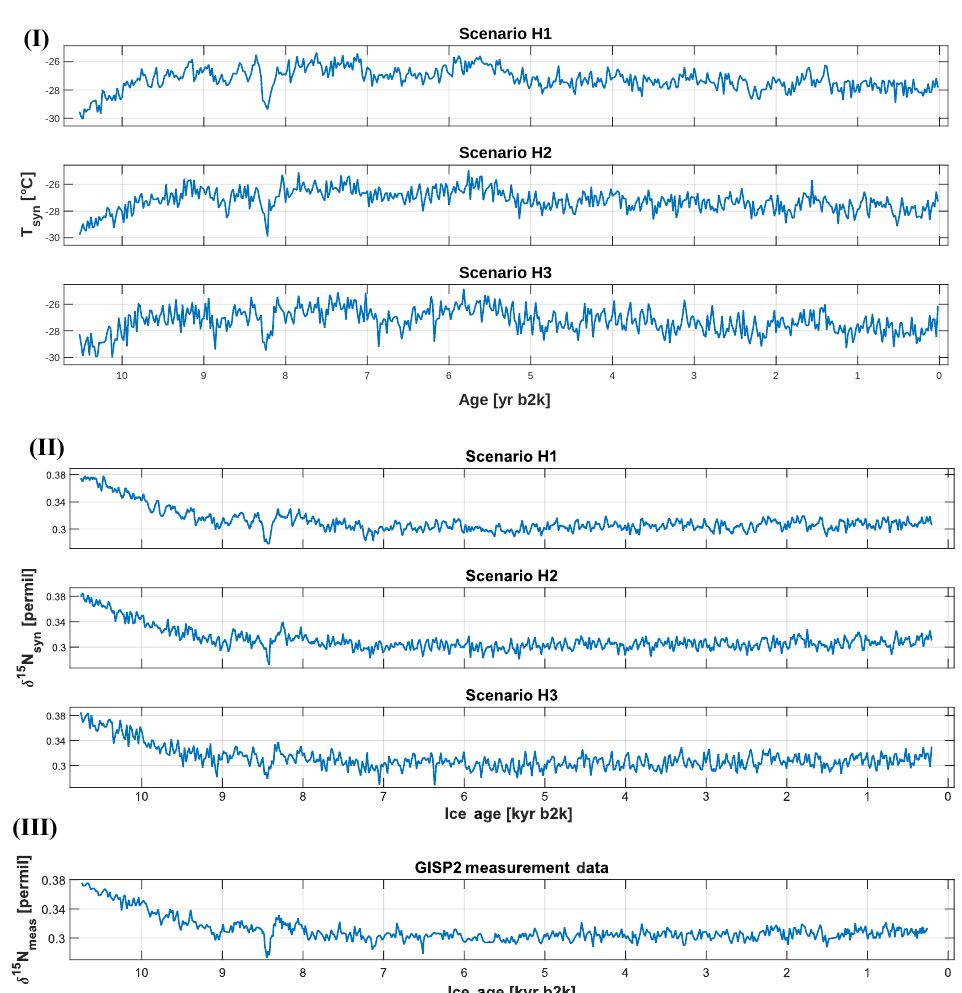
Figure 5. (I) Synthetic target surface-temperature scenarios H1–H3. (II) Corresponding synthetic δ 15 N target time series H1–H3. (III) GISP2 δ 15 N measured data (Kobashi et al.,